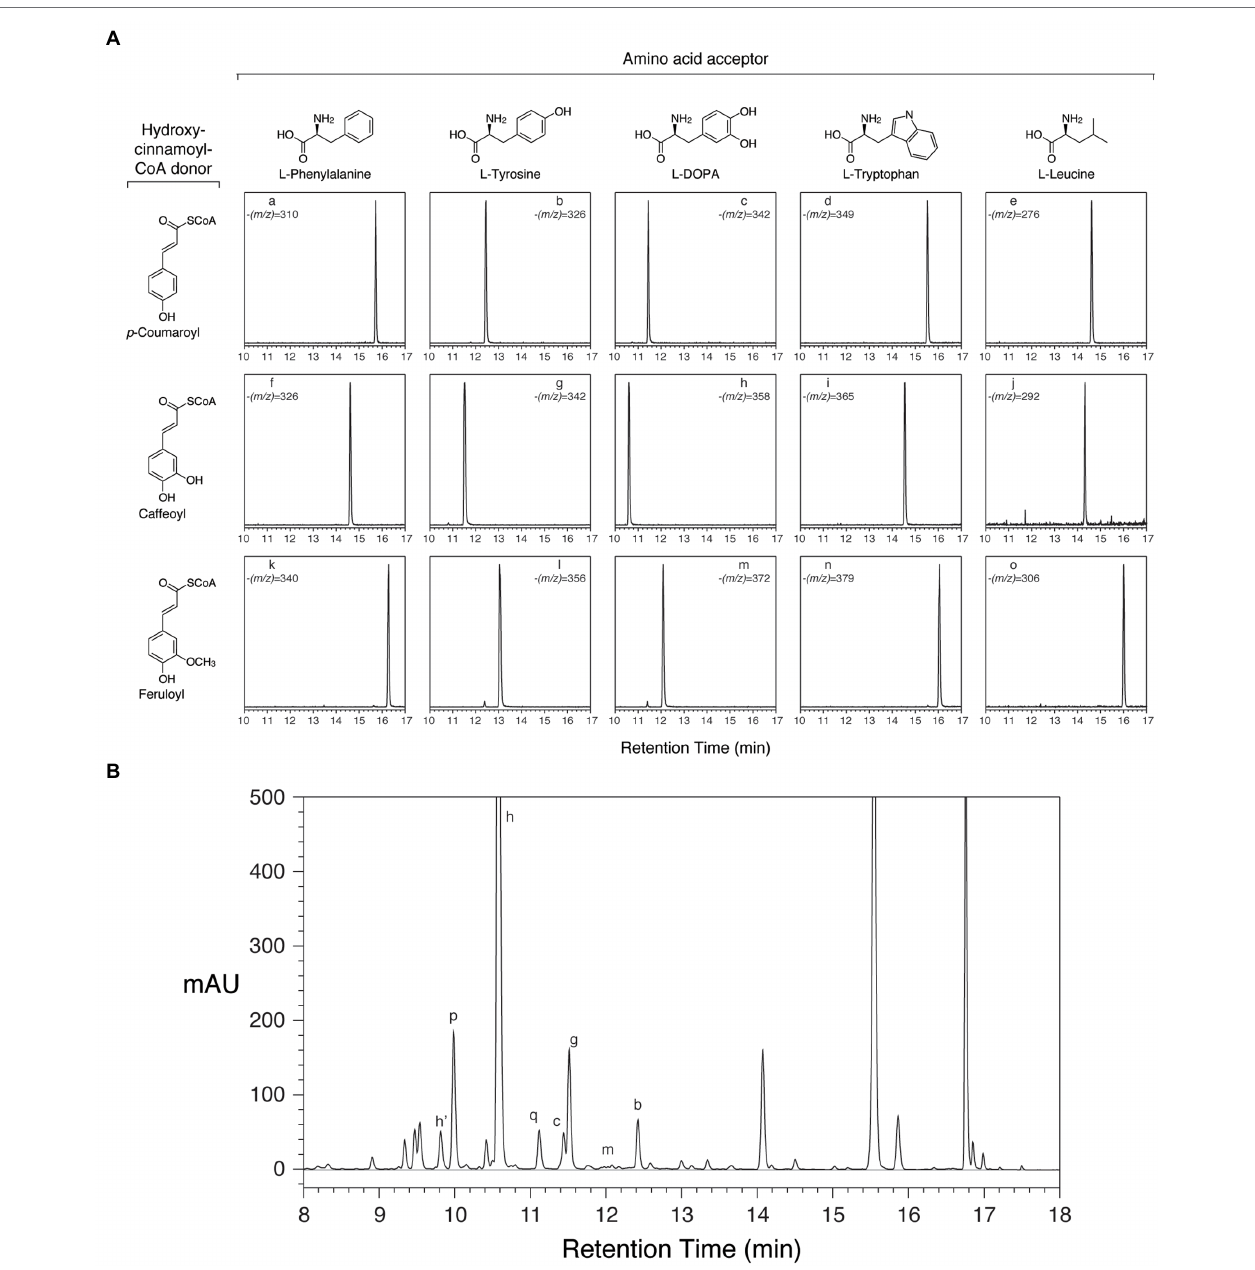
FIGURE 4 | Reaction products from HDT expressed in Escherichia coli correspond to phenolic compounds in red clover leaves. Peak assignments are detailed in Table 6. (A) HPLC separation and selective ion MS detection of in vitro HDT reaction products of the indicated donor and acceptor substrates. The ( m/z ) value monitored in each chromatogram is indicated. (B) HPLC separation of phenolics extracted from unexpanded red clover leaves with PDA (250–500 nm)